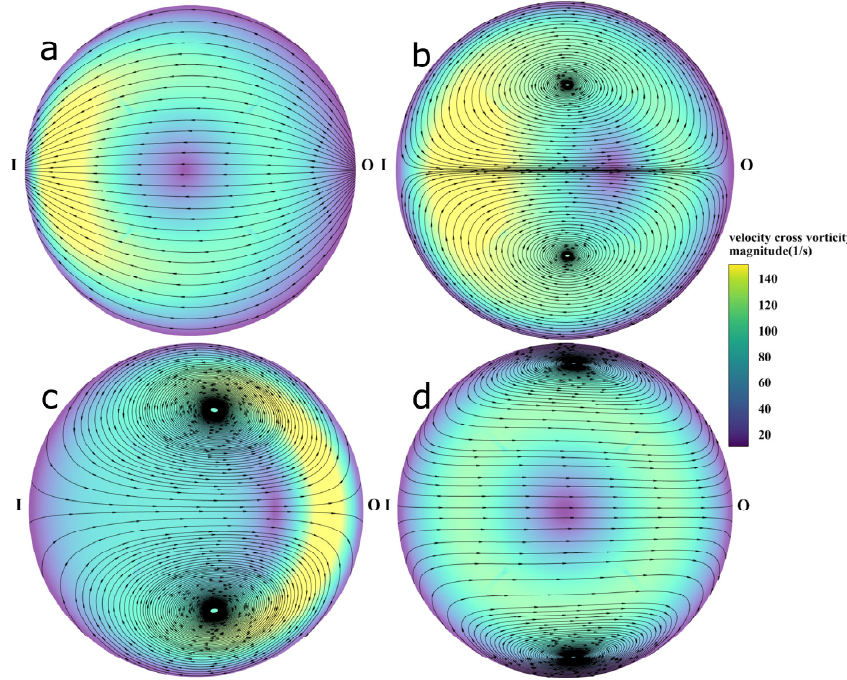
Figure 18. In the 45 ◦ channel at the conveying rate of 2.85 cm 3 /s, ( a – d ) are the profiles of the velocity cross vorticity magnitude and the projected streamlines on the second to the last slices from the inlet to the outlet .